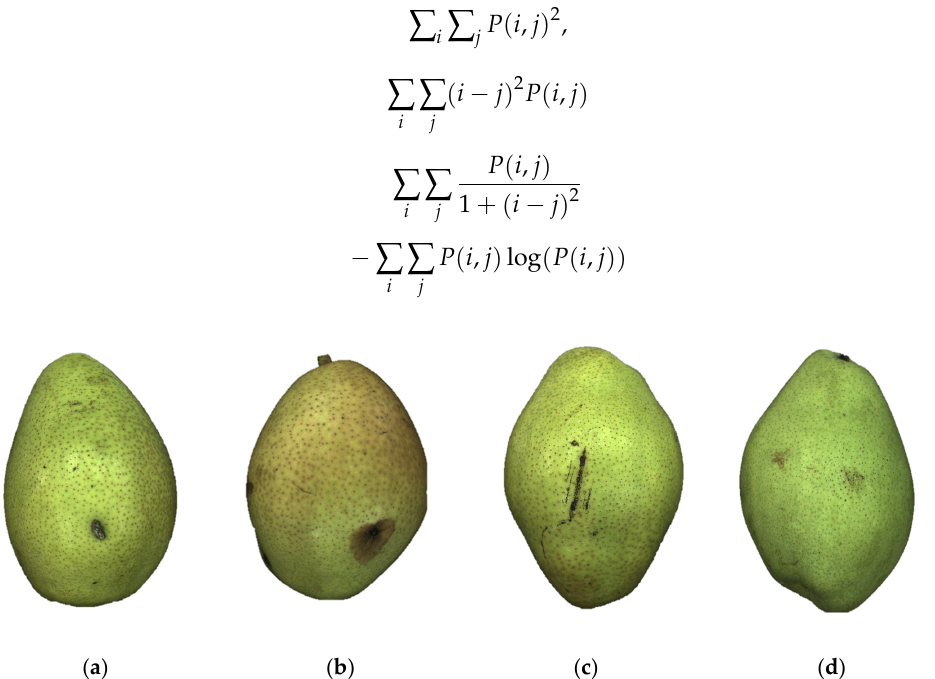
Figure 5. Schematic diagram of surface defects of pears. ( a ) Stabbed defect. ( b ) Bruised defect. ( c ) Abraded defect. ( d ) Rusty defect.